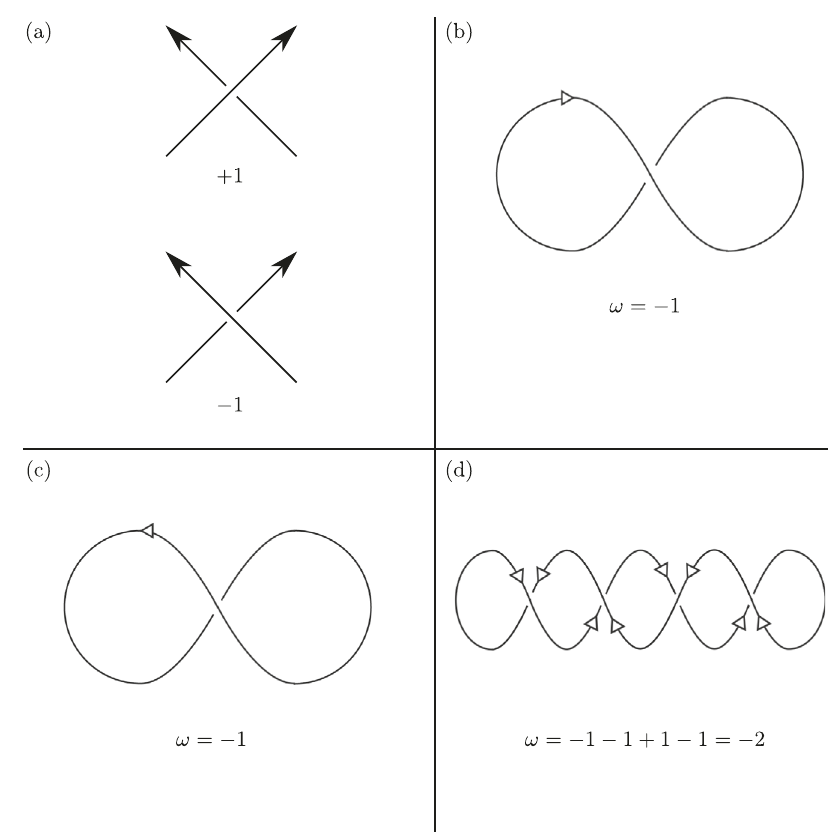
Fig. 7 Sign of a crossing and self writhe. a Right-hand rule for the sign of the oriented crossing. b , c The self-writhe of an oriented loop is the sum of the signs of the self-crossings in the diagram. In order to compute it, an orientation must be chosen for the loop; however, the end result does not depend on this choice. d Self writhe of a loop with four self-crossings.